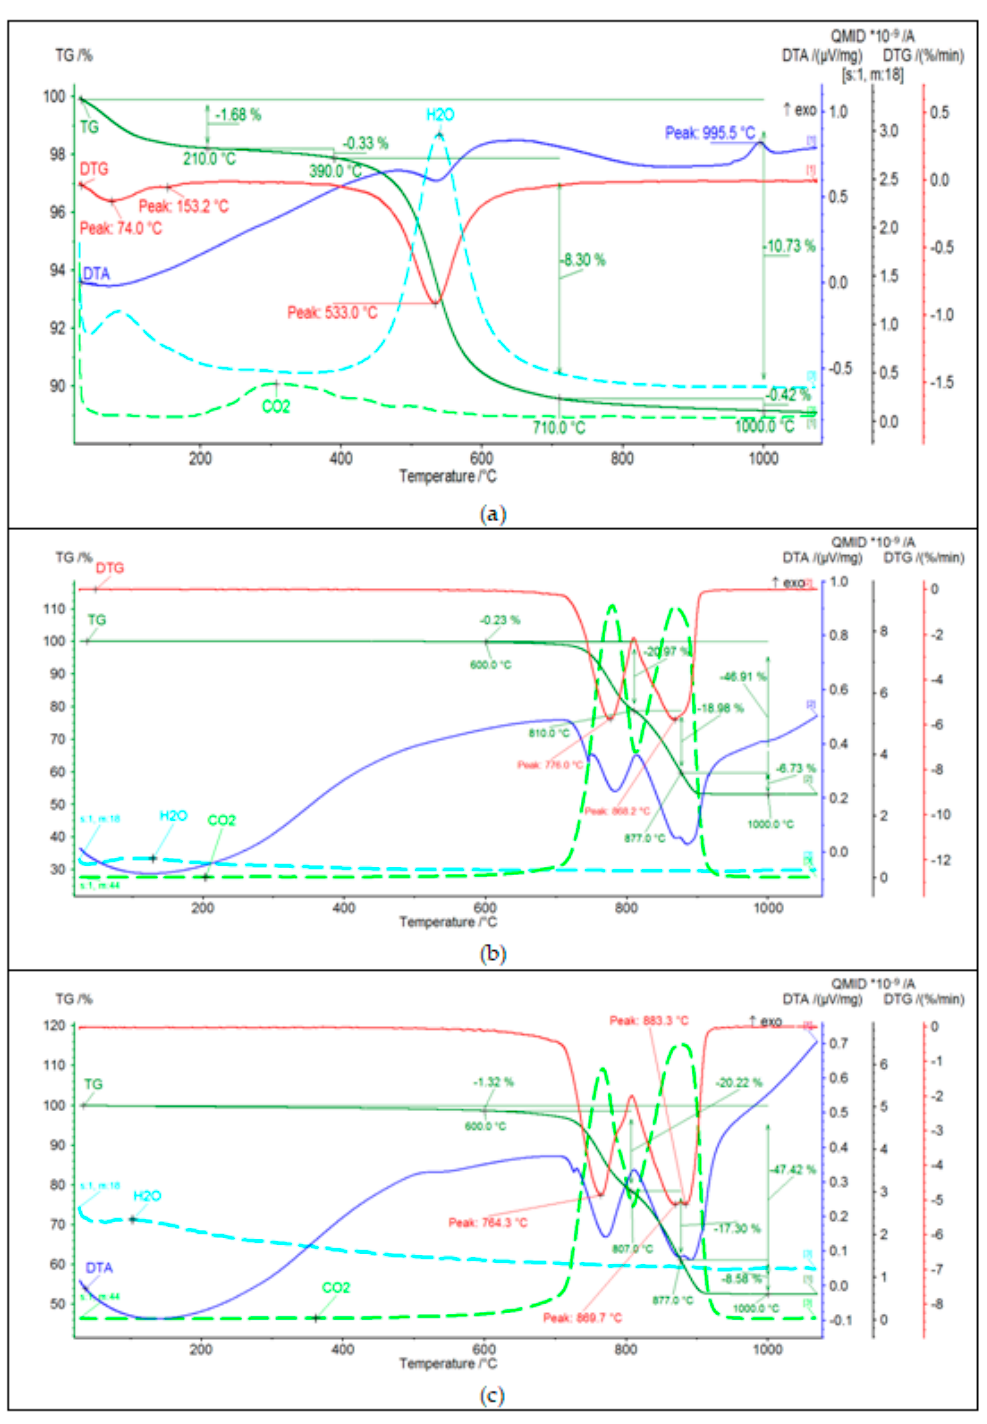
Figure 4. Thermal analysis (DTA, TG, DTG, and EGA patterns) of ( a ) Borkowice clay, ( b ) Ołdrzychowice dolomite: 13.18 µ m, ( c ) Ołdrzychowice dolomite: 34.67 µ m.